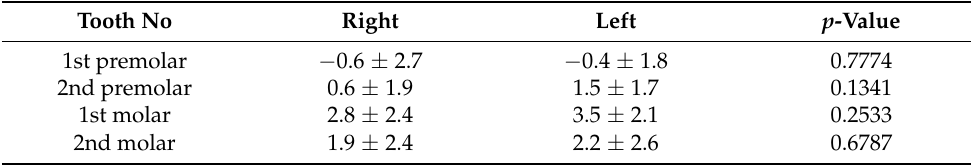
Table 2. Mean change, SD and p -value of the difference between left and right sides. Tooth No Right Left p -Value 1st